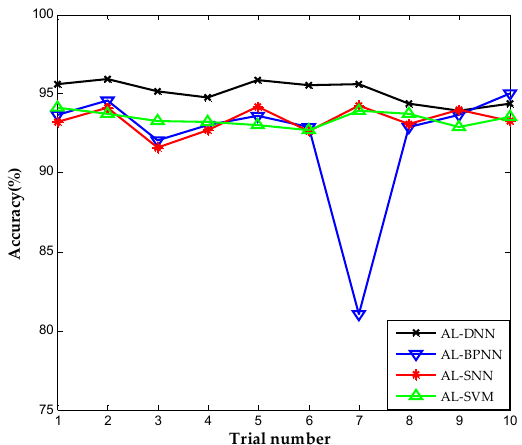
Figure 7. Correct diagnosis rate of active learning for deep neural network (AL-DNN), active learning for back propagation neural network (AL-BPNN), active learning for single neural network (AL-SNN), and active learning for support vector machine (AL-SVM).